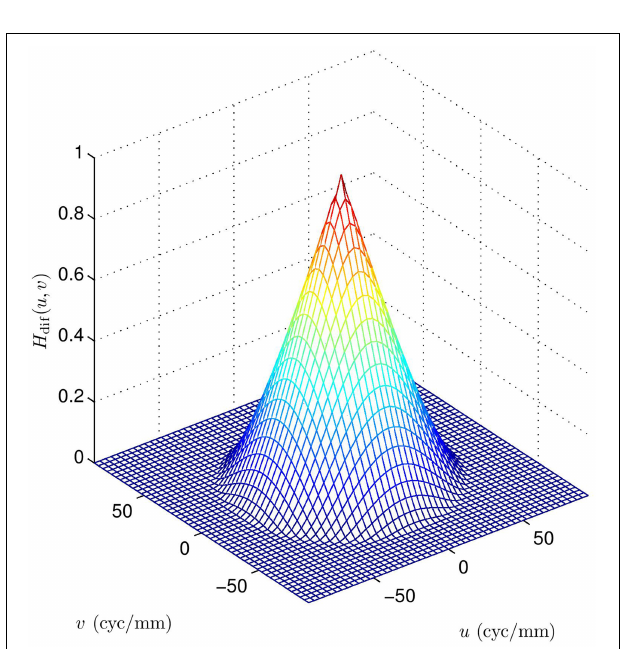
FIGURE 2 | Nonuniform sampling grid composed of the registered collection of three translationally shifted frames, each with a pixel spacing of 30 μ m. FIGURE 3 | Diffraction OTF, H dif ( u , v ) , for MWIR system with F = 3 . 33